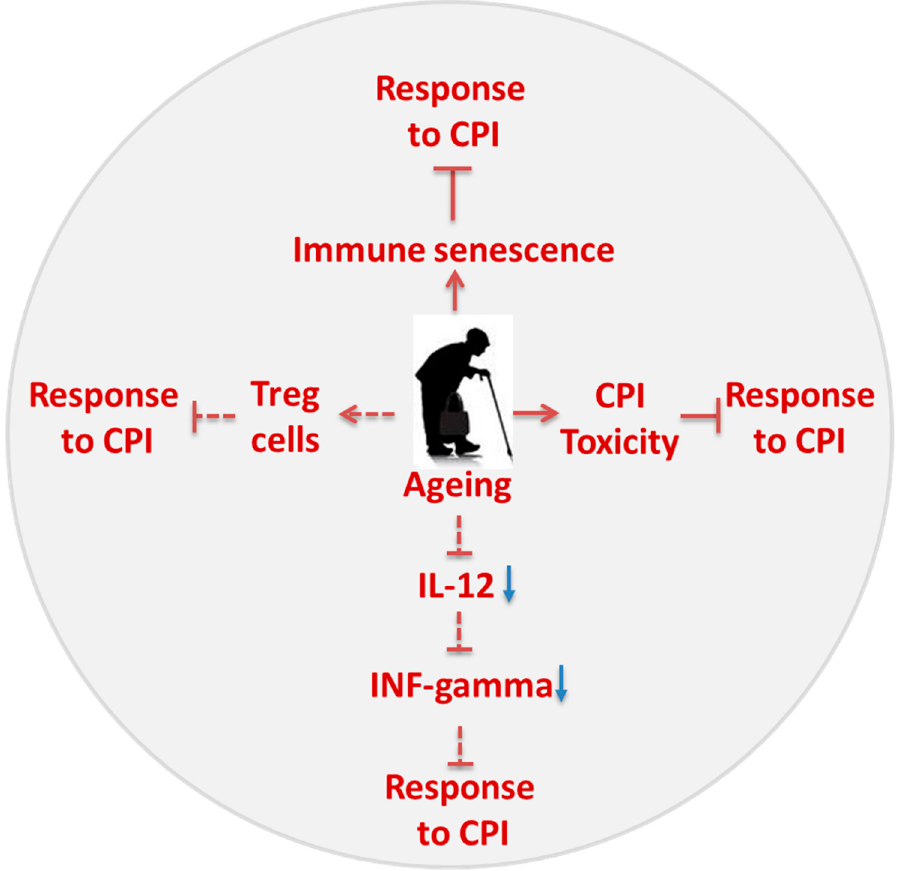
Figure 2. Ageing reduces responsiveness to CPI.